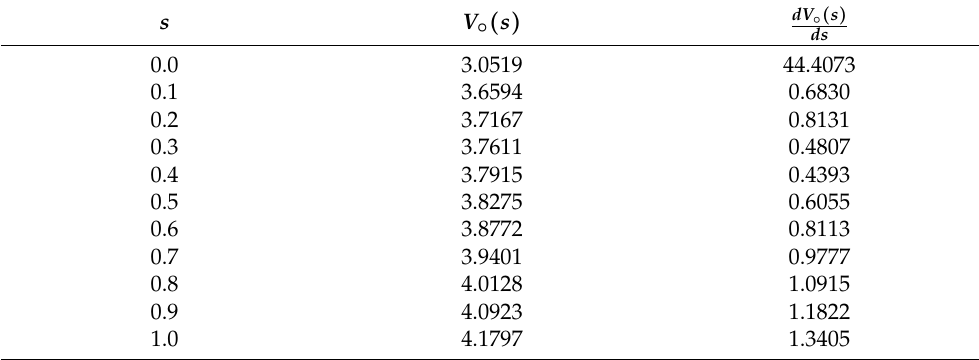
Table 2. A Sample OCV–SOC